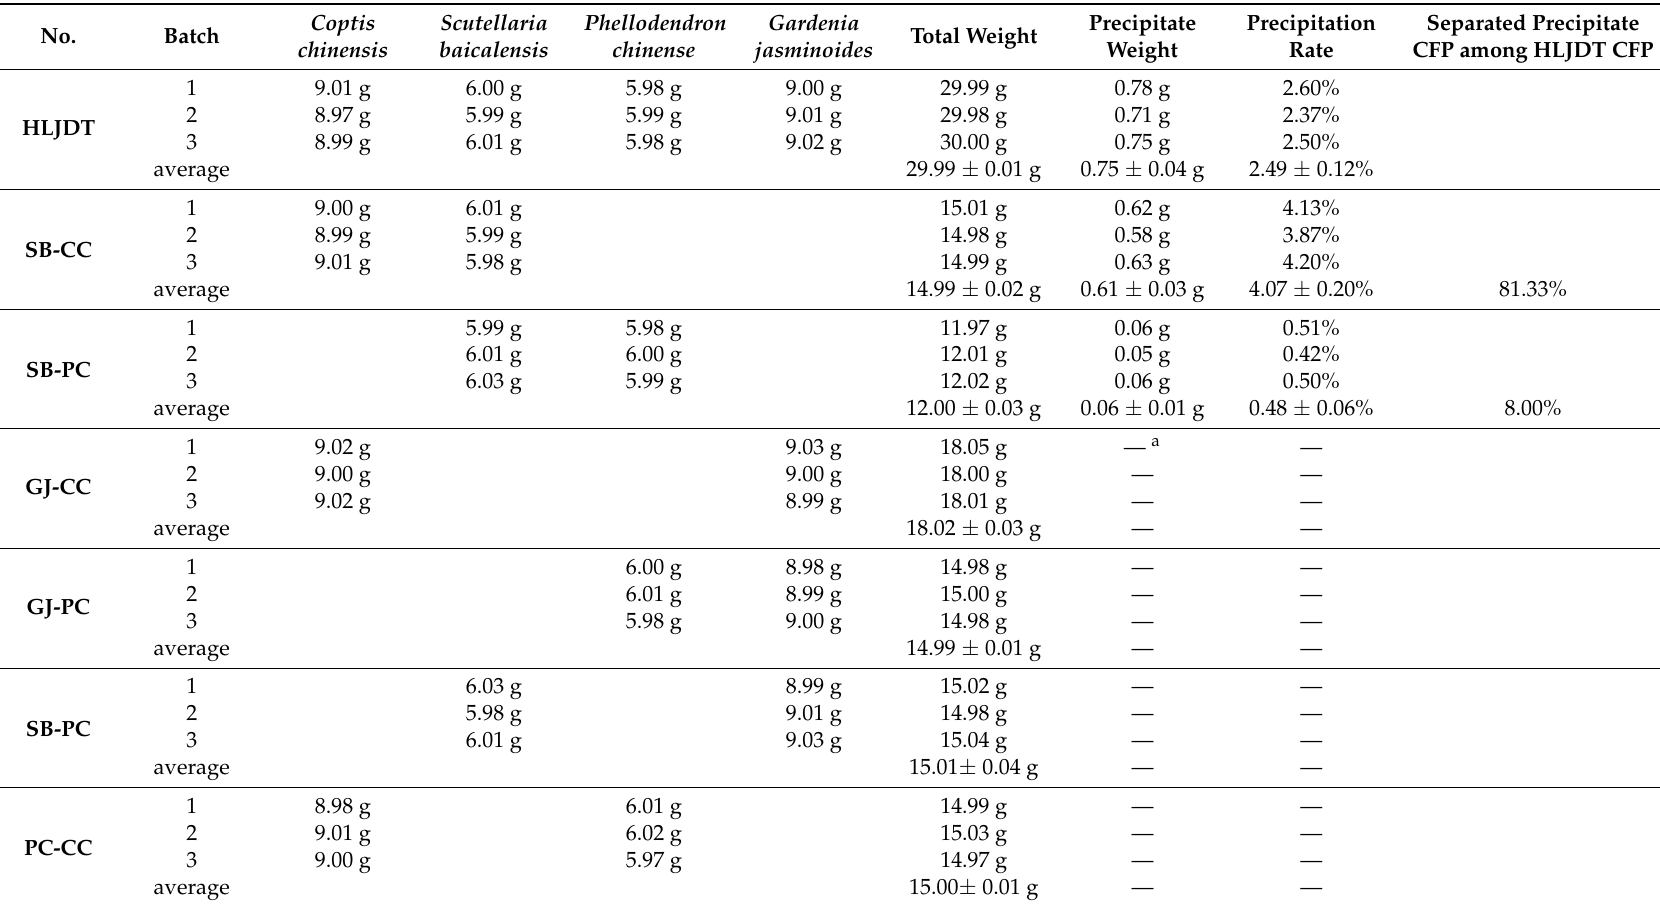
Table 1. The formation rate of HLJDT CFP and seven separated prescriptions from different batches.